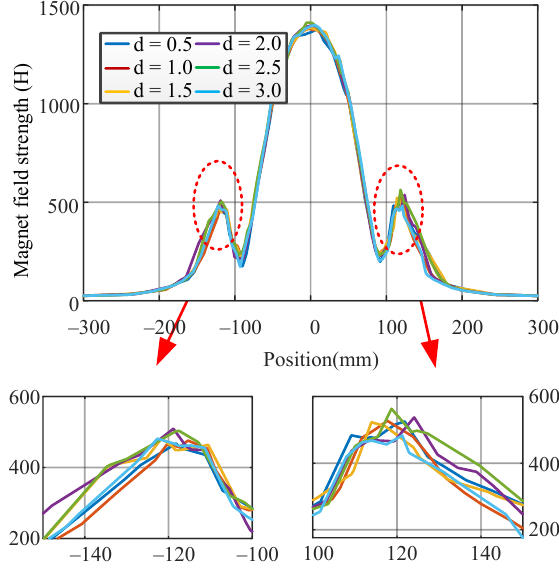
Figure 10. Magnetic field strength curves of shields with different depths.